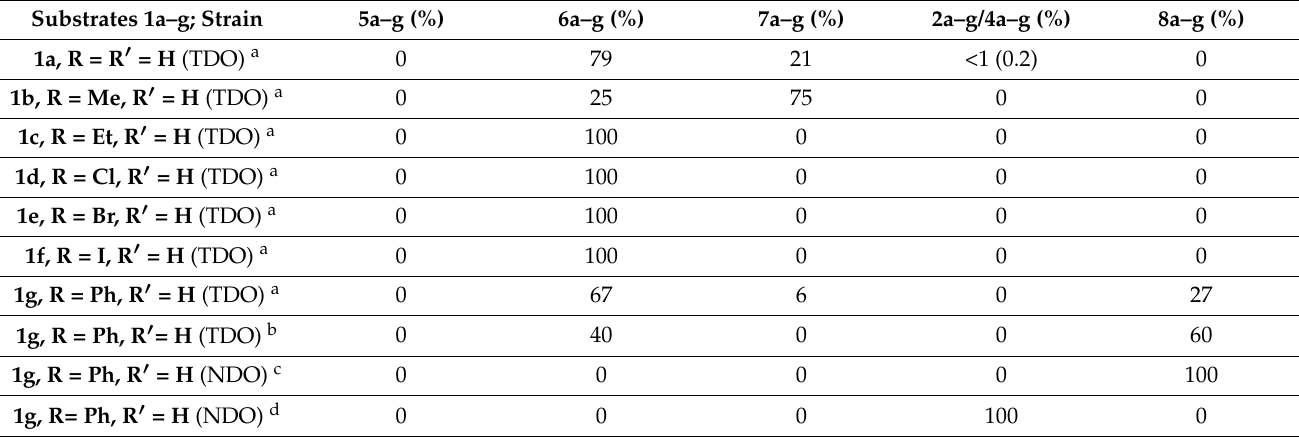
Table 1. Relative yields of metabolites from thiophenes 1a-g [12]. Substrates 1a-g; Strain